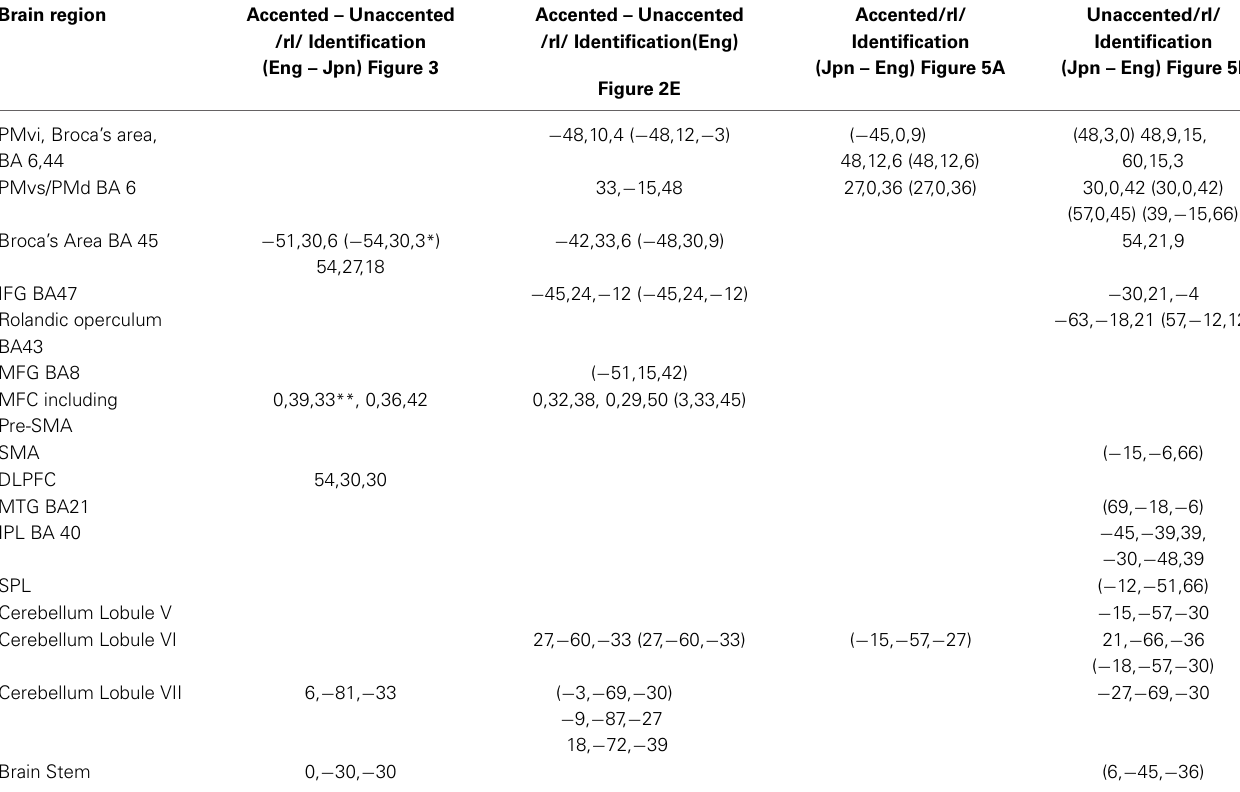
Table showing clusters of activity for the various contrasts thresholded at p < 0.001 uncorrected. Coordinates in Parentheses denote those that are significant when using phonetic identification performance as a covariate of non-interest. Jpn., Japanese; Eng., English; BA, Brodmann area; PMvi, Ventral inferior premotor cortex; PMvs, Ventral superior premotor cortex; PMd, Dorsal premotor cortex; IFG, Inferior frontal gyrus; MFG, Middle frontal gyrus; MFC, Medial frontal cortex. SMA, Supplementary motor area; DLPFC, Dorsolateral Prefrontal Cortex; MTG, Middle Temporal Gyrus; IPL, Inferior Parietal Lobule; SPL, Superior parietal lobule. Negative × MNI coordinates denote left hemisphere and positive × values denote right hemisphere activity. *Cluster was not significant when thresholded at p < 0.001 uncorrected but was significant at p < 0.0015 uncorrected. ** Significant at p < 0.05 FWE correcting for multiple comparisons across the entire volume. activity in left and right PMvi/Broca’s, right PMvs/PMd